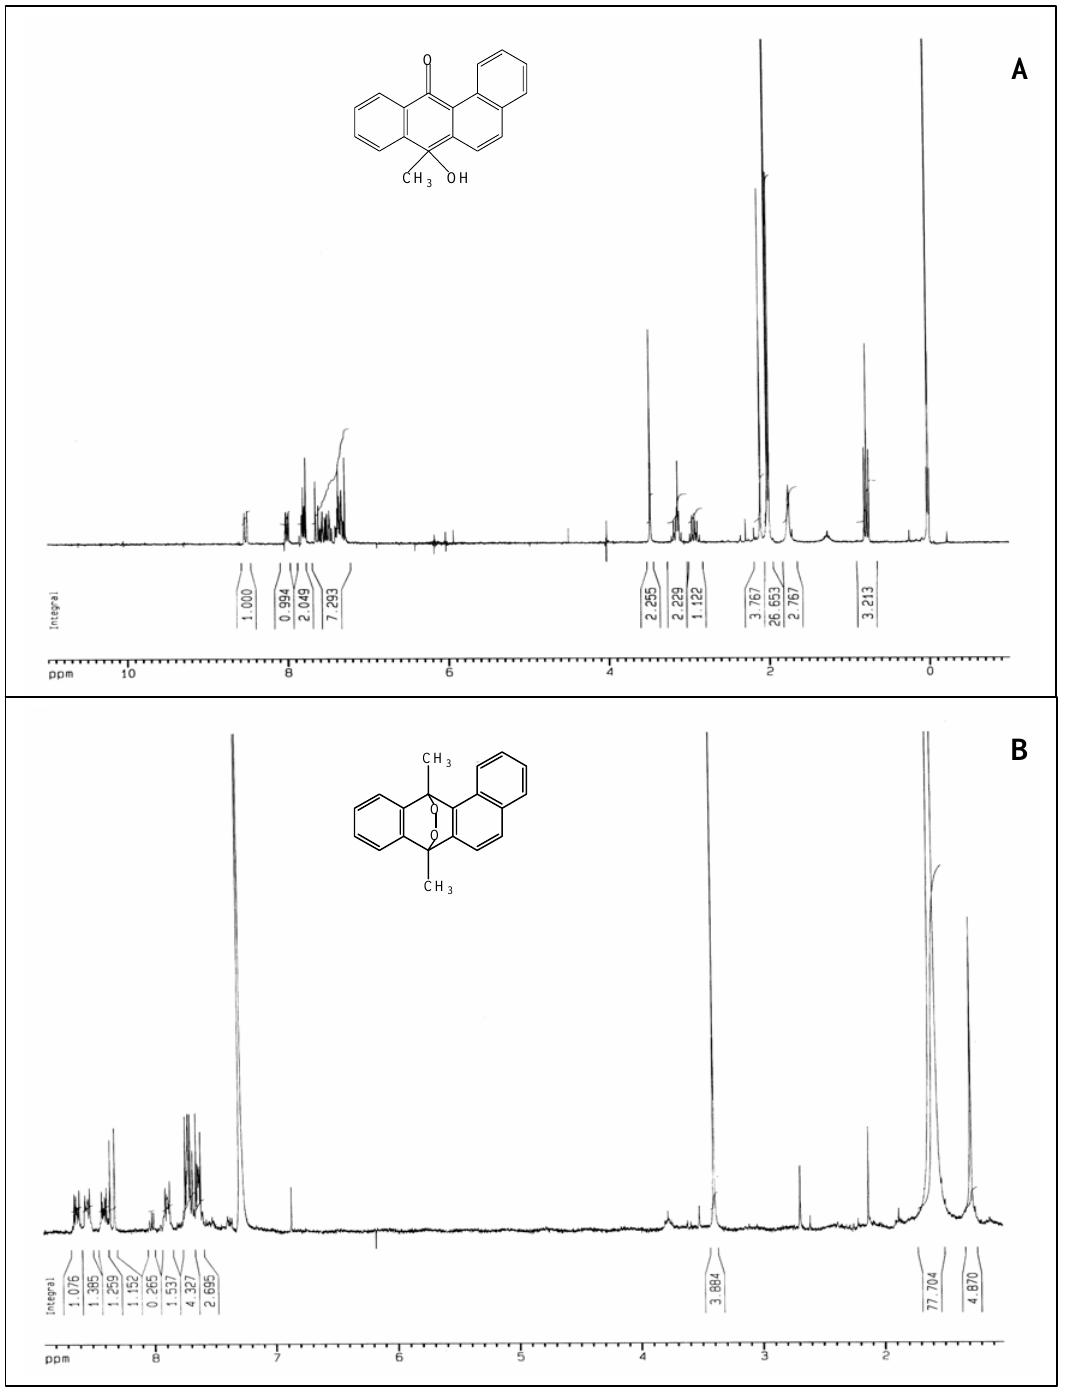
Figure 4: 1 H-NMR spectra of purified P5 (A) and P8 (B) of DMBA